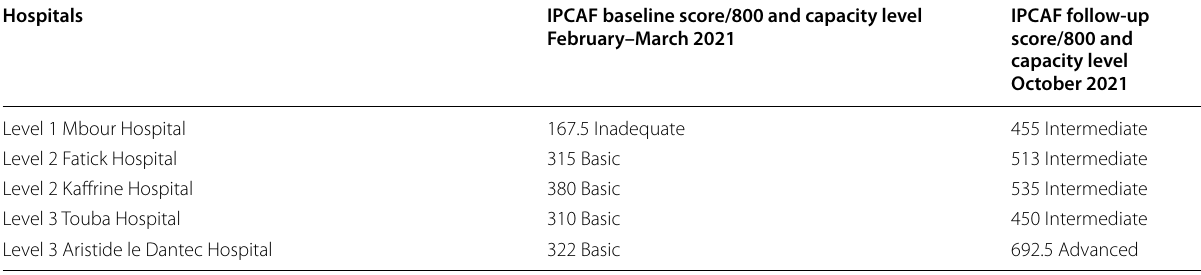
Table 6 IPCAF review of program-supported hospitals in Senegal before and after IPC improvement actions Hospitals